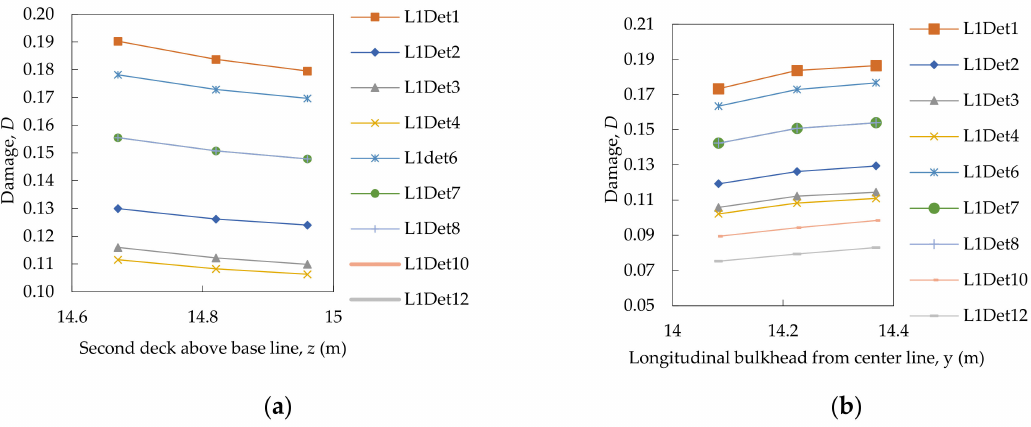
Figure 8. Evolution in the fatigue damage for longitudinal No. 1 ( L1 ) of the different structural details. ( a ) Modification in the second deck height from base line, ( b ) modification in the longitudinal bulkhead distance from